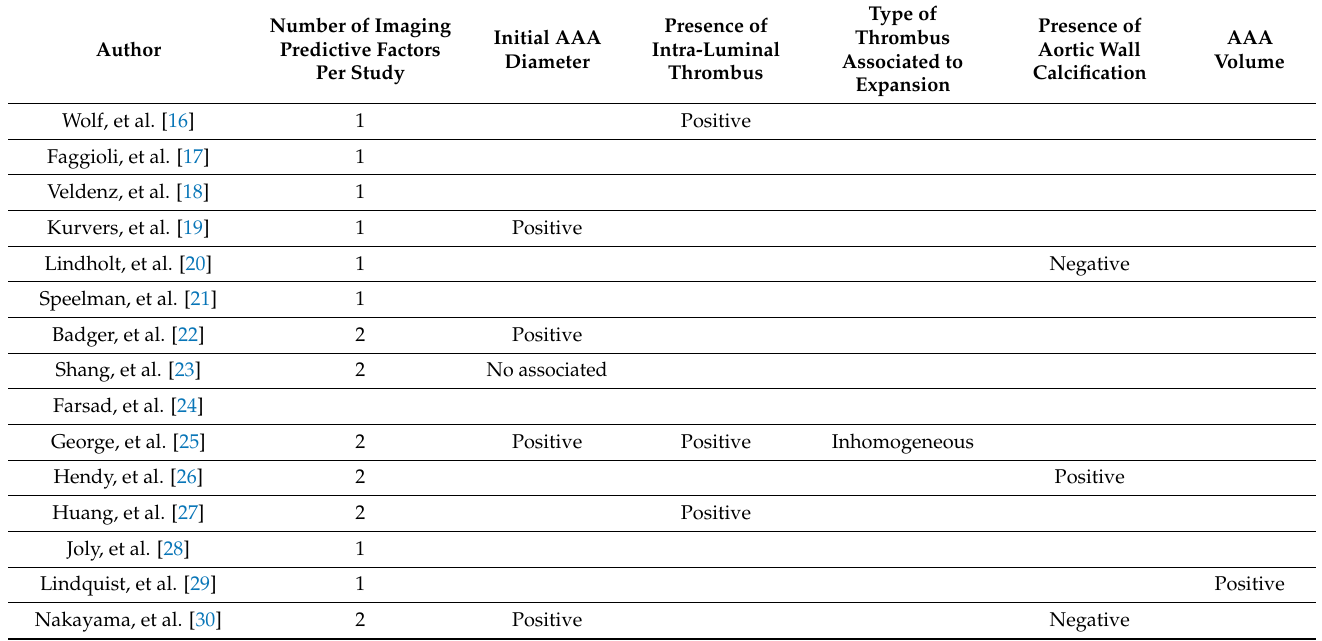
Table 4. Out of 23 studies, the initial diameter was characterized as a prognostic factor associated to aneurysm